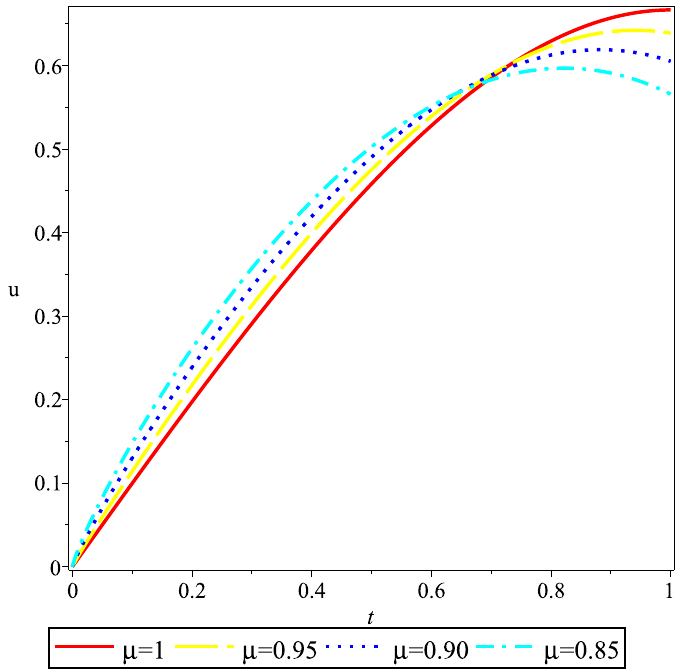
Figure 8. Response of u ( t ) with respect to t for distinct values of µ .